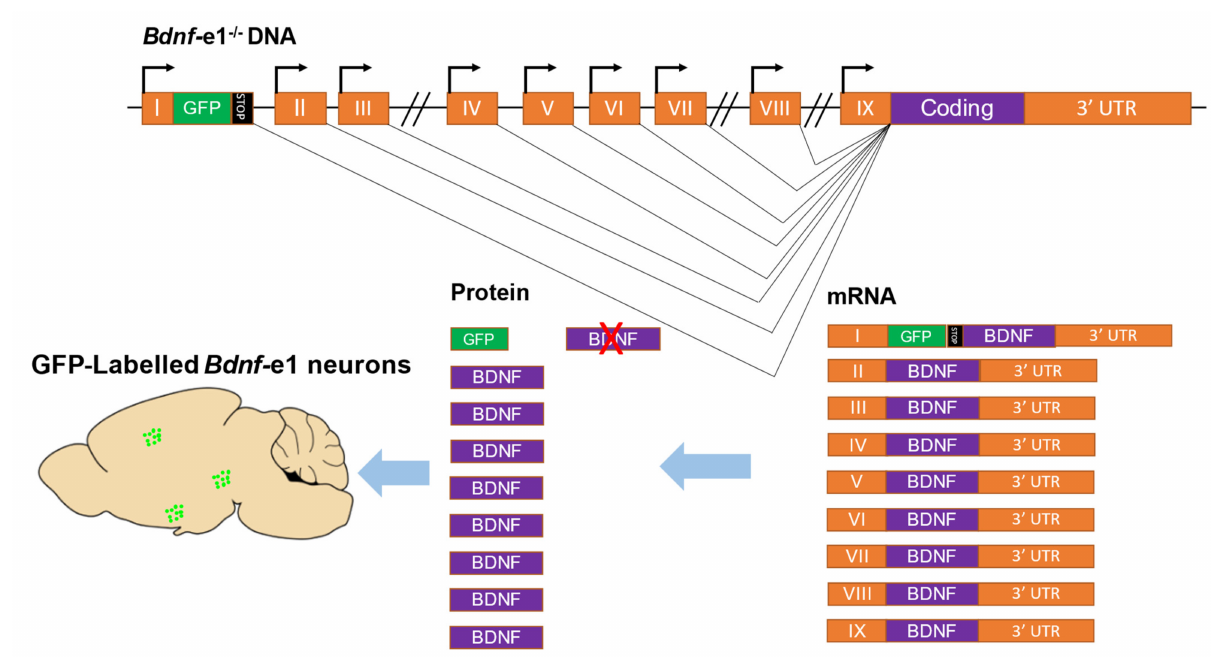
Figure 2. Strategy for generating mice with disruptions of specific Bdnf transcripts. As an example, the disruption of transcripts driven by Promoter I in mice is shown. The rodent Bdnf gene contains nine promoters that drive nine exons (I to IX). Exons can be transcribed from their respective promoters and alternatively spliced to the coding region to translate the same brain-derived neurotrophic factor (BDNF) protein. To generate Bdnf -e1 − / − mutant mice, a GFP-STOP cassette (the GFP sequence followed by multiple stop codons) was inserted after Exon I. In these mice, transcripts driven by Promoter I express GFP, which can be used as a marker for labeling Bdnf -e1 neurons, but not BDNF protein due to the presence of stop codons. The orange boxes represent exons, the black lines represent introns, the green and black boxes represent the GFP-STOP cassette, and the bent lines with arrows represent the transcription start site, and the green dots represent Bdnf -e1 expressing